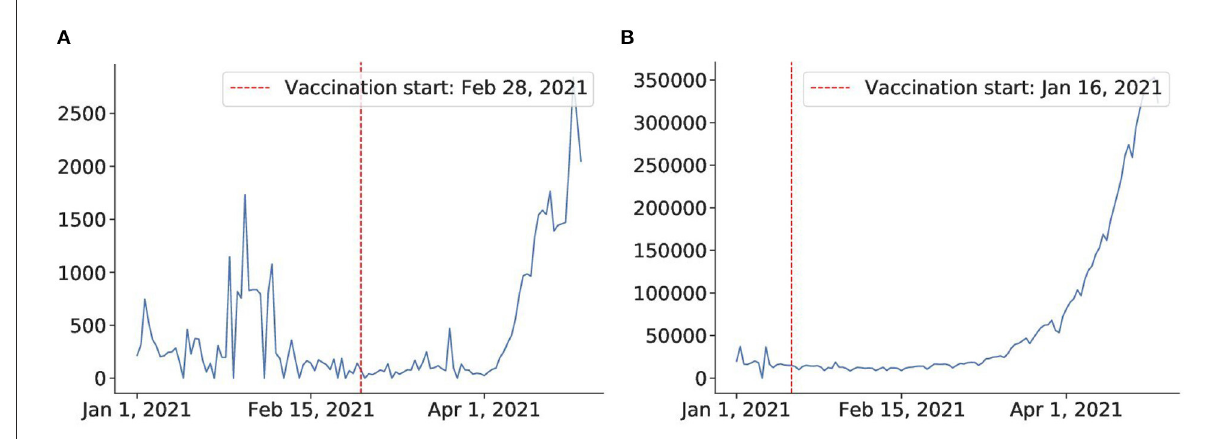
FIGURE13 Vaccine fails to mitigate virus in Thailand and India. (A) Thailand after vaccination on Feb 28. (B) India after vaccination campaign on Jan